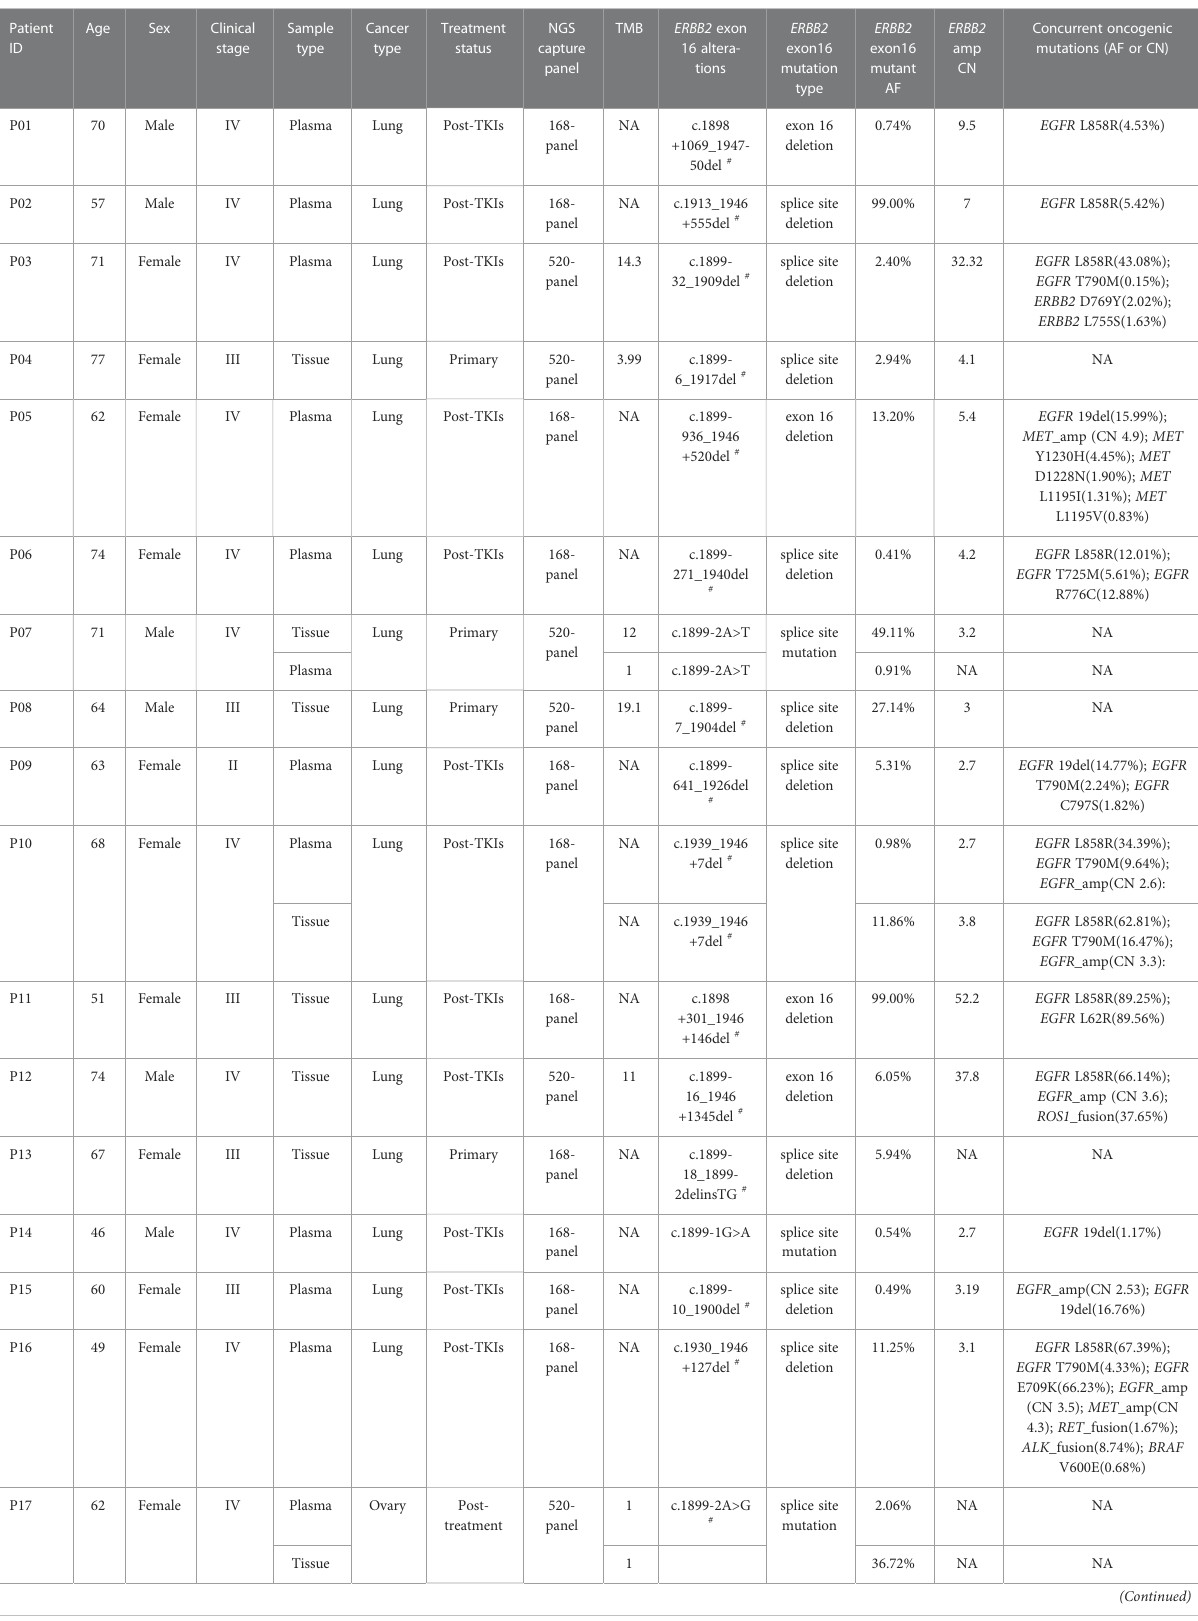
TABLE 2 Detailed clinical and mutational pro fi le of the 22 patients detected with ERBB2 exon 16 alterations in Cohort 1. Patient